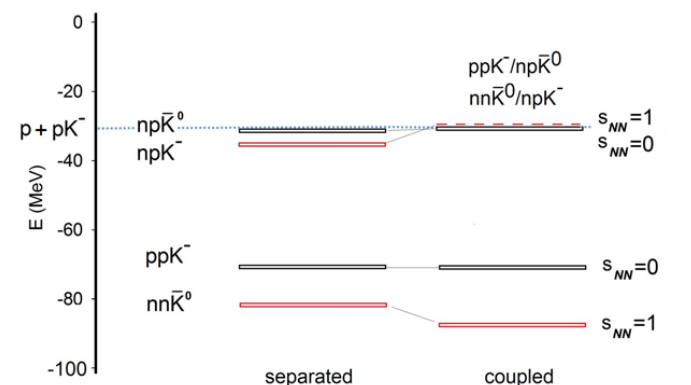
Figure 3: Spectrum of ppK − / np ¯ K 0 and nn ¯ K 0 / npK − bound (double lines) and reso- nance (dashed line) states. The two-body threshold p +( pK − ) is shown by the dotted line. The effect of the coupling is presented as a "repulsion of levels" and is shown by connecting lines. The energies is reassured from the three-body threshold p + p + K − . The spin of the nucleon pair is